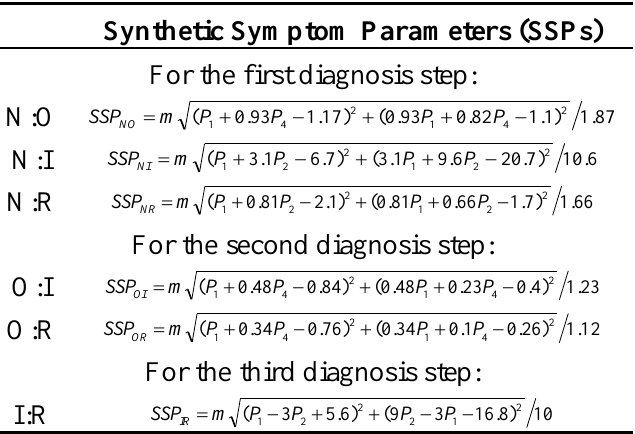
Table 4. SSP Formula for each sequential diagnosis